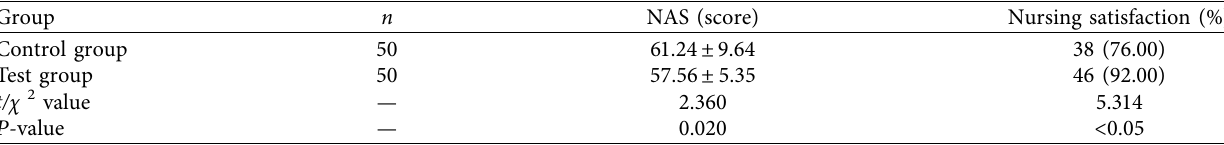
Table 5: Comparison of nursing satisfaction and nursing quality assessment between the two groups (n (%), x ± s ).